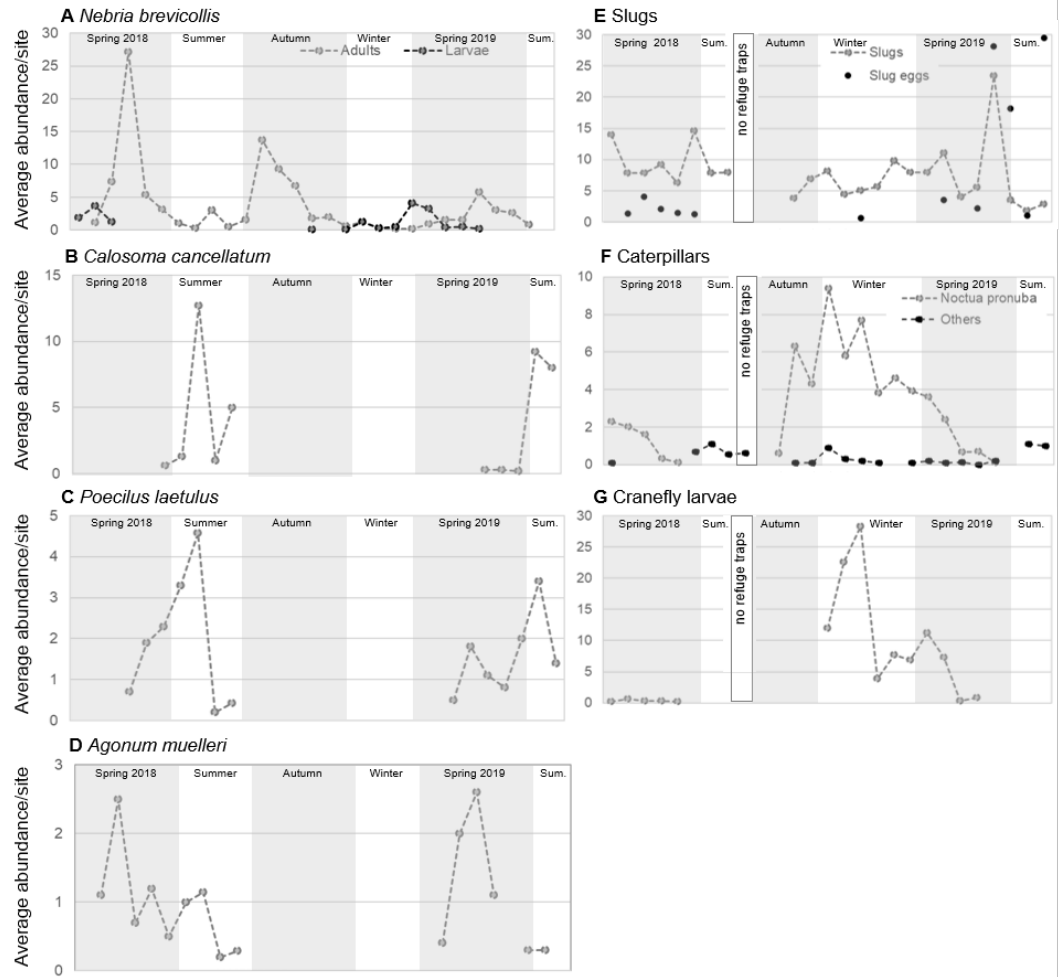
Figure 1. Average activity density per site for Nebria brevicollis ( A ), Calosoma cancellatum ( B ), Poecilus laetulus ( C ), Agonum muelleri ( D ), slugs ( F ), caterpillars ( F ) and cranefly larvae ( G ) throughout the